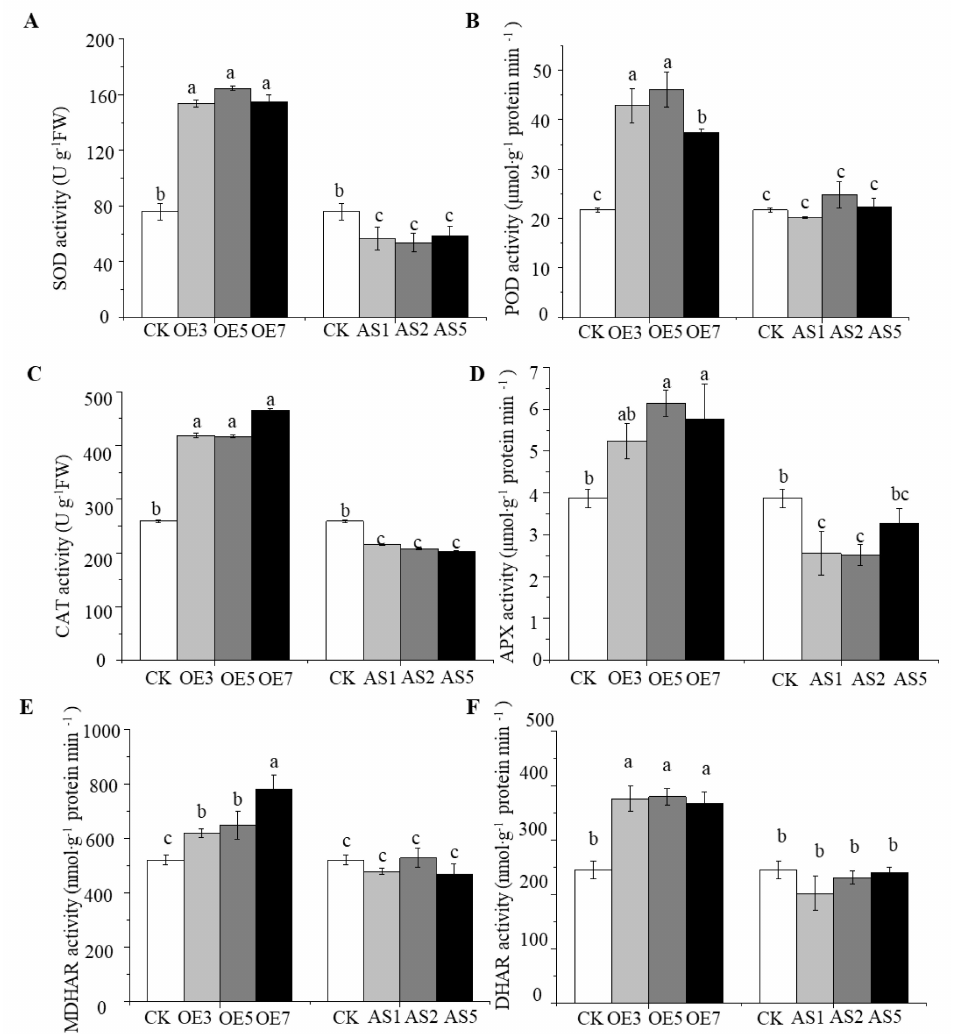
Figure 7. Antioxidant enzyme activities in the leaves of the control, CsGSH2- overexpressing (OX), and antisense (AS) plants at 48 h after propamocarb application. ( A ) Superoxide dismutase (SOD) activity. ( B ) Peroxidase (POD) activity. ( C ) Catalase (CAT) activity. ( D ) Ascorbate peroxidase (APX) activity. ( E ) Monodehydroascorbate reductase (MDHAR) activity. ( F ) Dehydroascorbate reductase (DHAR) activity. Data are the means of three replicates with SE, and different letters indicate significant differences ( p <